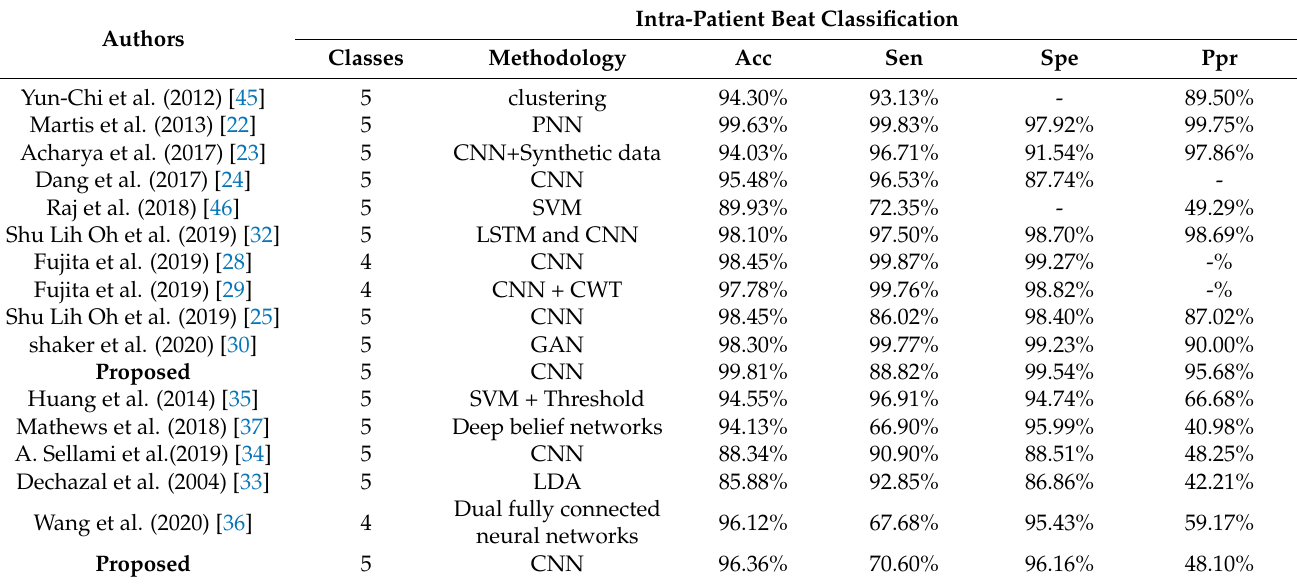
Table 8. Comparison of classifications for intra-patient and inter-patient beat